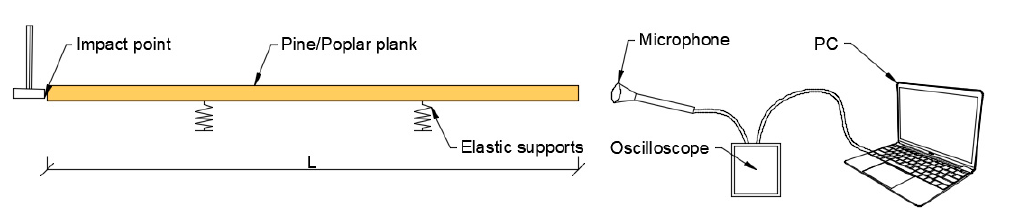
Figure 2. ART layout for planks. L = Plank length.